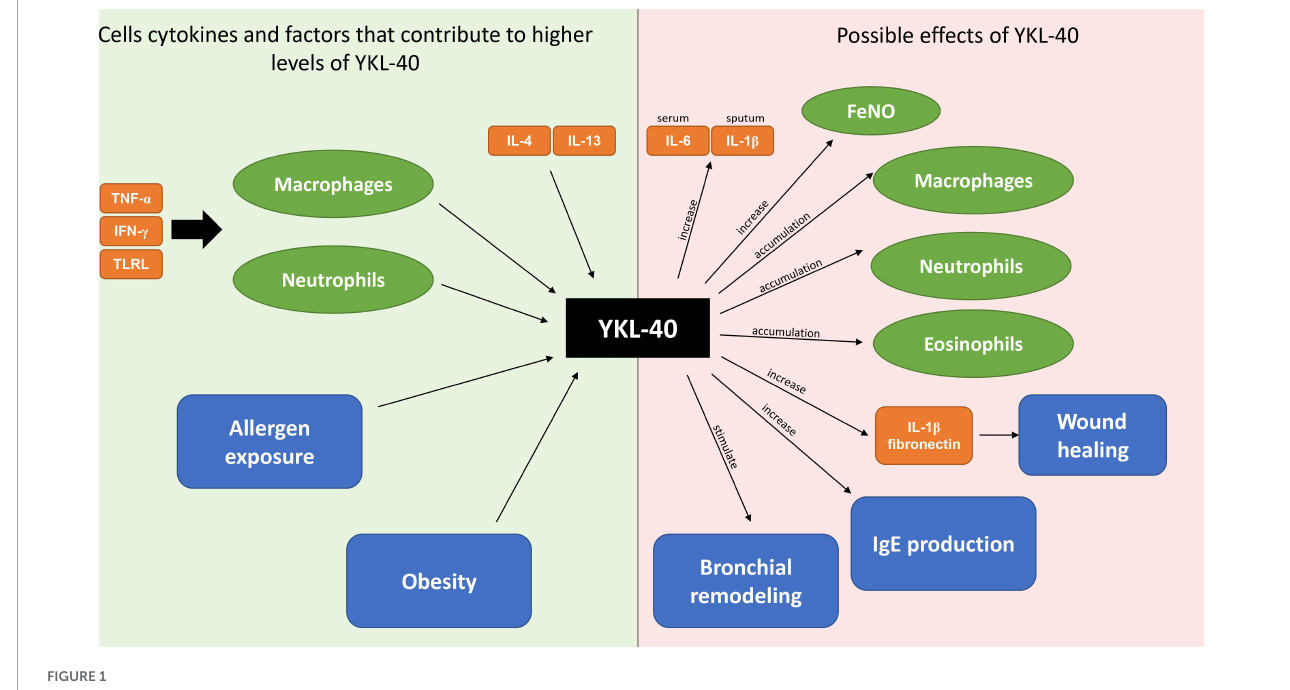
FIGURE1 Origins and biological effects of